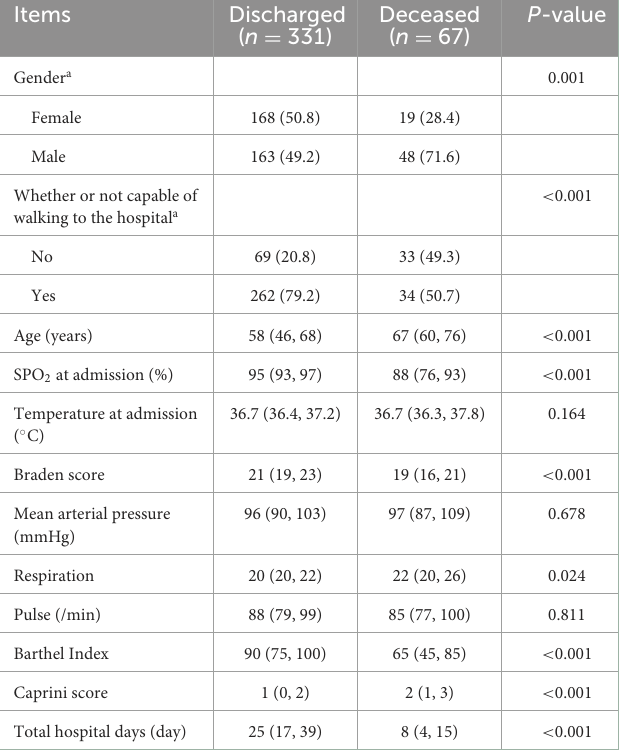
TABLE 1 Demographic characteristics of the COVID-19 patients.